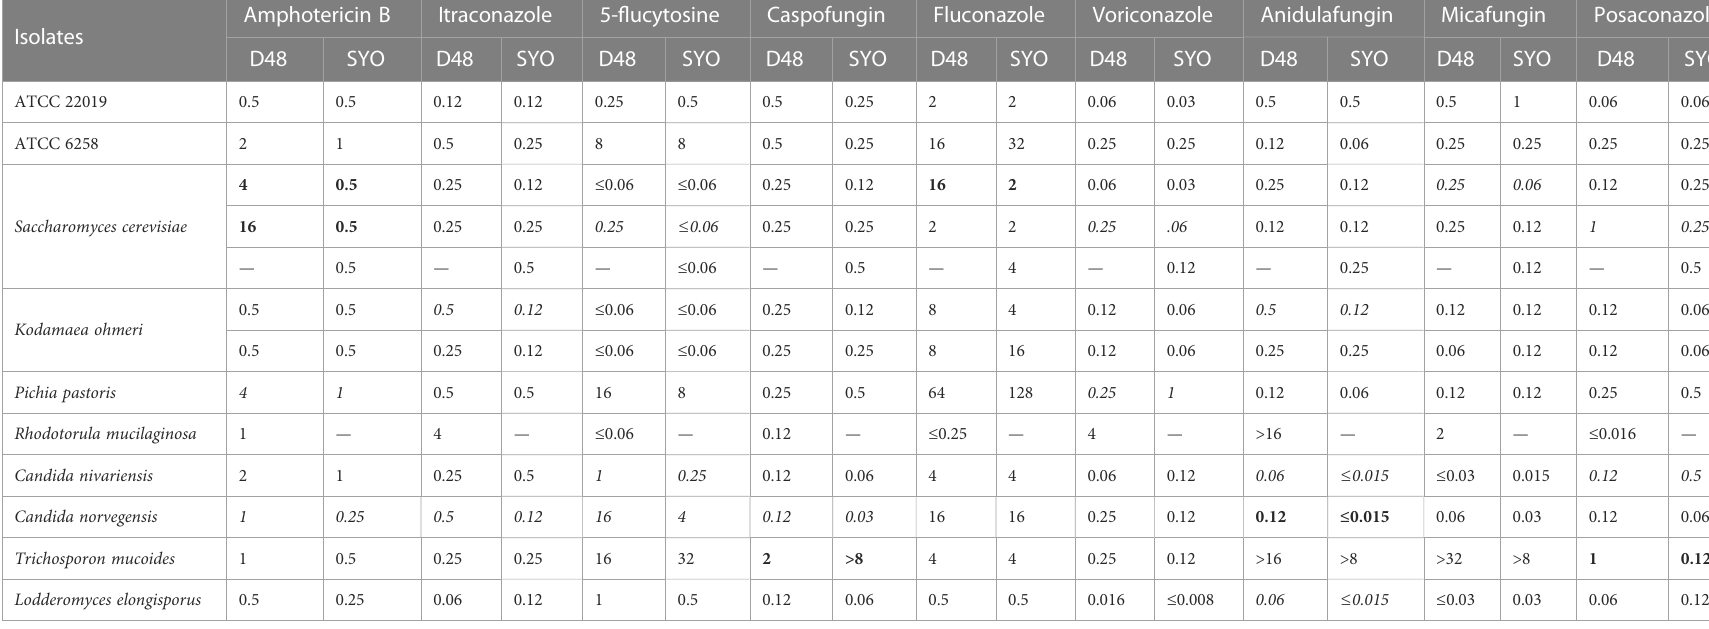
TABLE 2 Minimal inhibitory concentration ( m g/mL) detection results of D48 and SYO for quality control strains and rare clinical infection fungi .